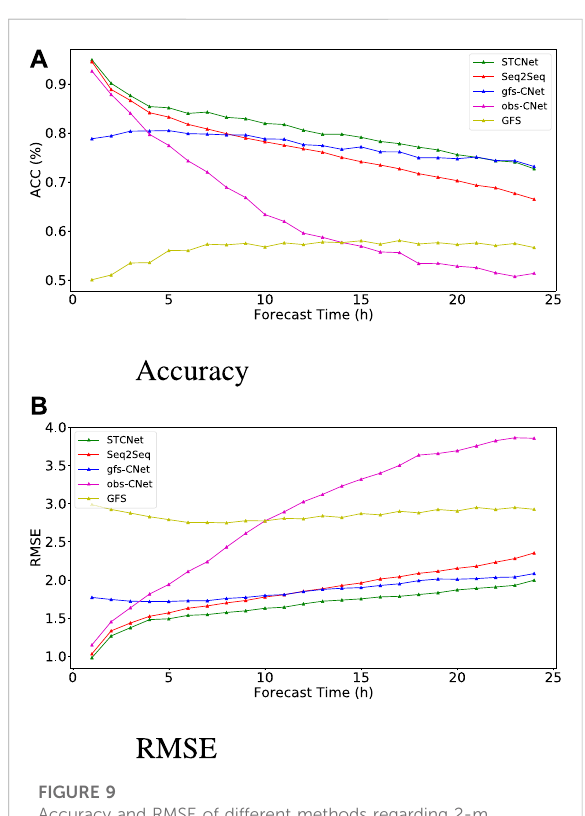
FIGURE 8 Accuracy and RMSE of different methods regarding 2-m temperature forecast with respect to forecast time.